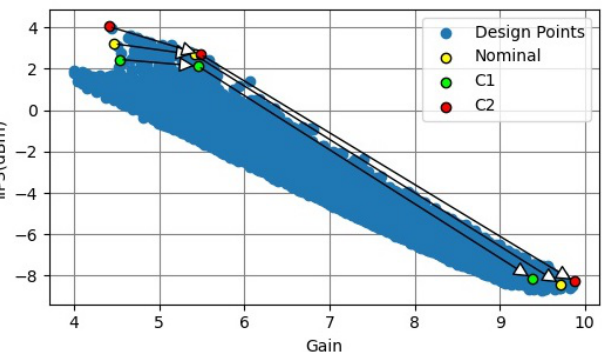
Figure 7. IIP3 vs. gain design space and optimal design points for the three corners: TT 27 ◦ C (Nominal), FF − 40 ◦ C (C1), and SS 125 ◦ C (C2).